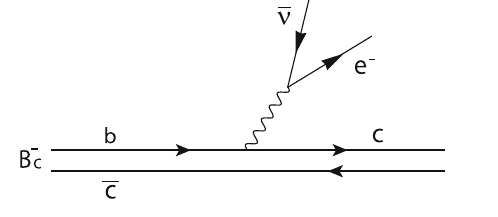
Fig. 1 Diagrammatic representation of the quark level for B c → ν